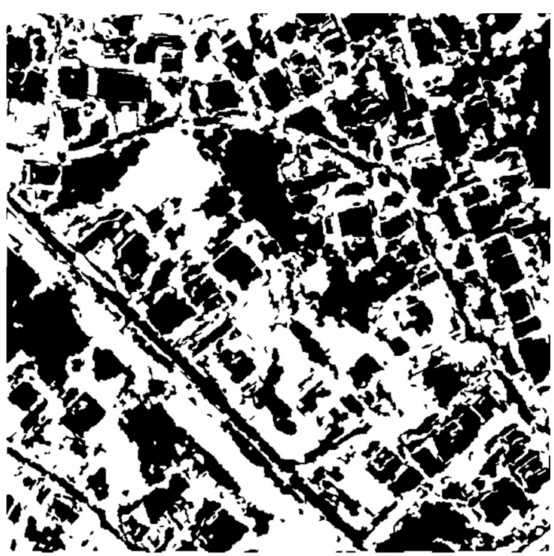
Figure 16. Truth ground of change in the expanded experimental area.